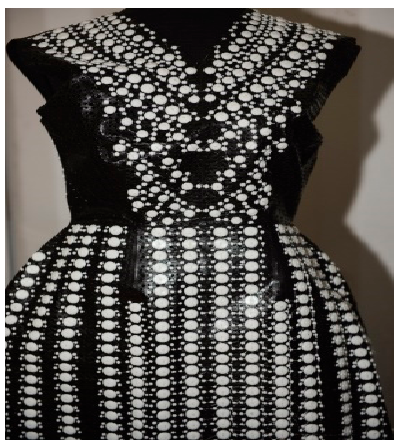
Figure 10. A 4D printed dress with colors [89] (Source https://juliadaviy.com/category/future-of- fashion/).